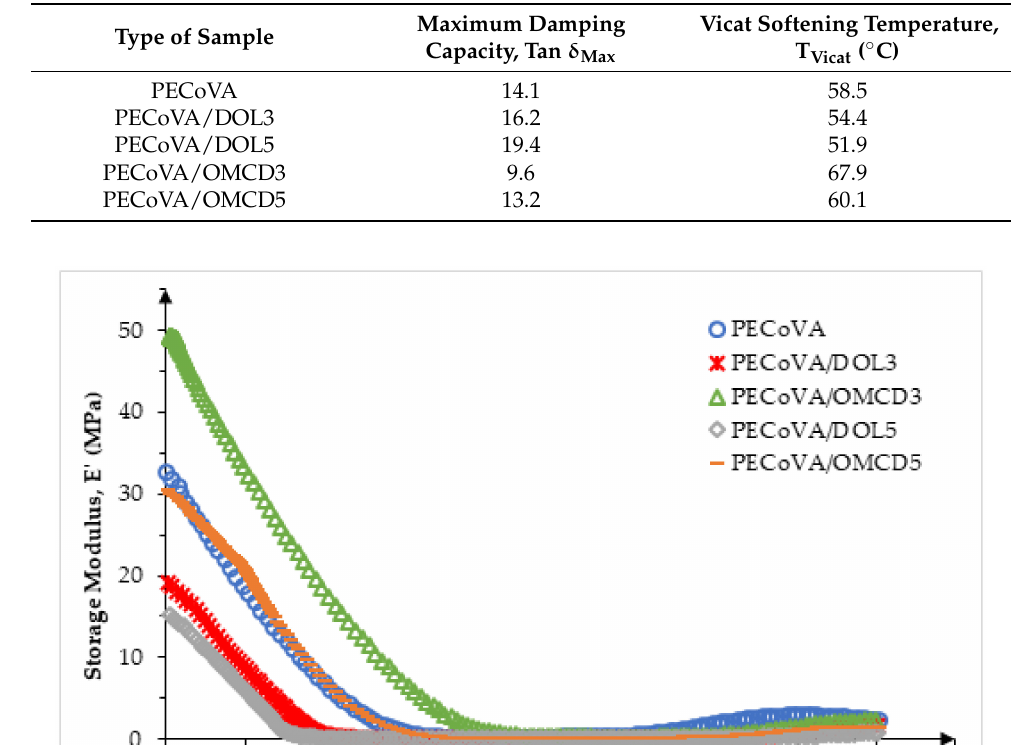
Table 7. Damping capacity of virgin PECoVA, PECoVA/DOL and PECoVA/OMCD composites.